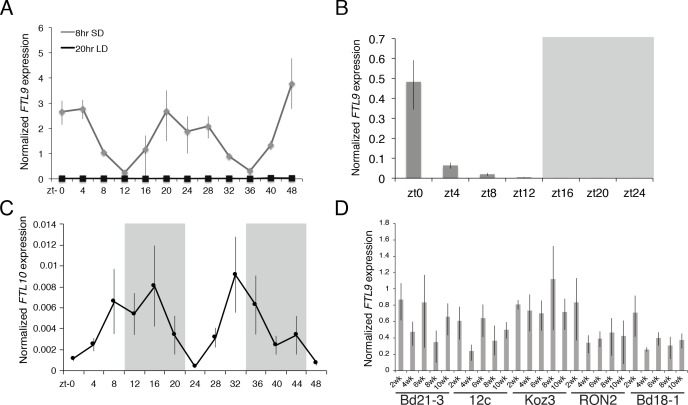
FTL9 and FTL10 diurnal mRNA expression.(A) Diurnal FTL9 mRNA fluctuation in 8 hr SD versus 20 hr LD. Koz3 plants were grown in SD or LD until the fourth-leaf stage was reached at which point the newly expanded leaf was harvested at several time points throughout a 48 hr diurnal cycle. In SD (8 hr light/16 hr dark) the dark periods were from zt 9–23 and 33–47. In LD (20 hr light/4 hr dark) the dark periods were from zt 20–23 and zt 44–47. (B) Plants were entrained under 8 h days until the fourth leaf stage was reached at which point the plant were grown in continuous darkness and the newly expanded fourth leaf was sampled every 4 hr for 24 hr. Shaded box represents subjective night. (C) Diurnal FTL10 mRNA expression pattern in 8 hr SD. For (A–C) values represent the average of four biological replicates ± standard deviation (four leaves per replicate). Shaded boxes represent dark periods. The experiment was repeated with similar results. Expression is normalized to UBC18 as in Ream et al. (2014). (D) FTL9 mRNA expression in Bd21-3, 12 c, Koz3, RON2 and Bd18-1 after 2–10 weeks of 8 hr SD exposure. The newly expanded leaf on the parent culm was harvested at the end of the given SD treatment in the middle of the photoperiod. FTL9 does not increase over time in SD in the accessions tested.